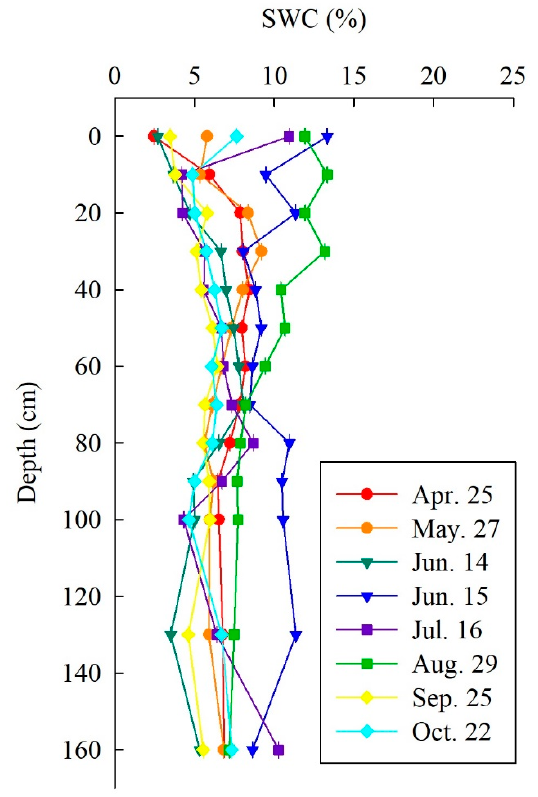
Figure 4. Vertical profiles (0–160 cm) of gravimetric water content of soil (SWC, %) (Mean ± S.D., N = 2).